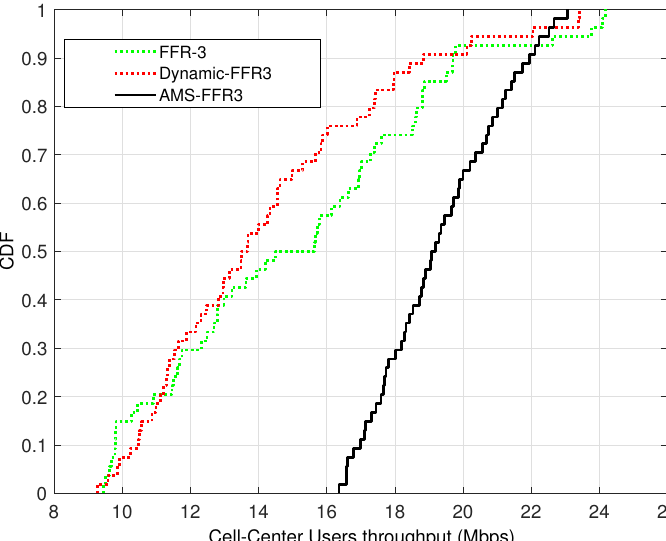
Figure 5. PDF of the cell-center users’ achievable